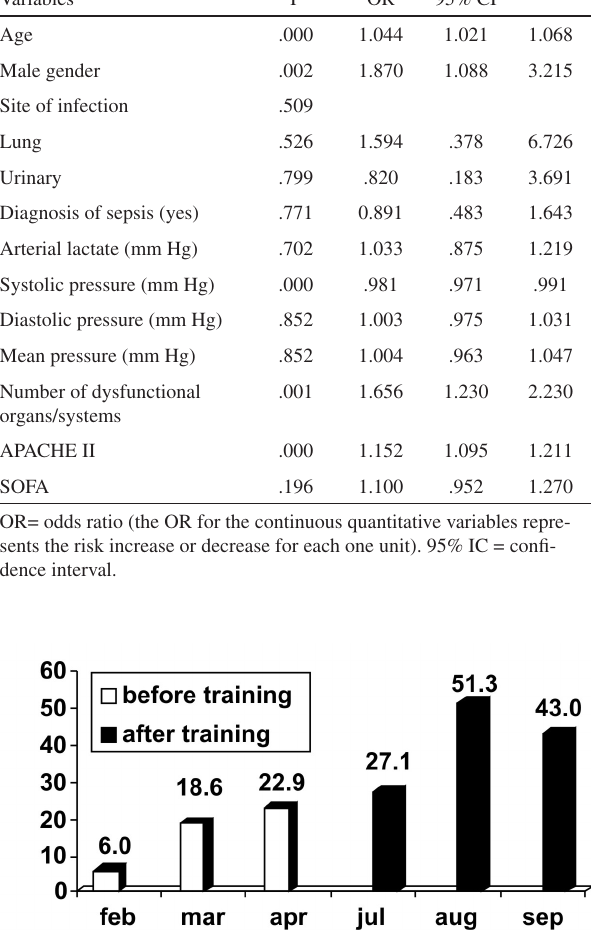
Figure 2 - Percentage of diagnosis of severe sepsis by the ED team before and after training. Chi-square test (p<0,001)